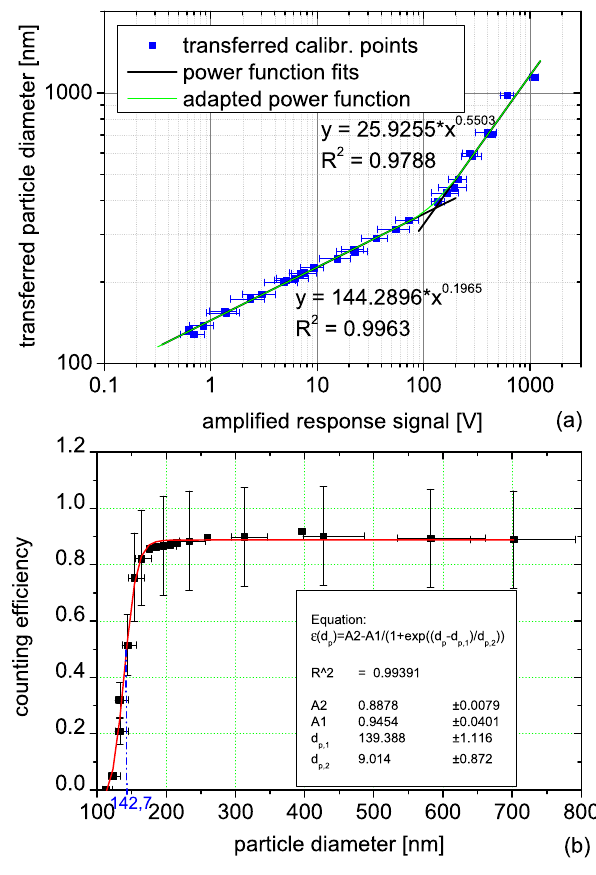
Fig. 2. OPC size calibration (left panel) and counting efficiency (right panel) obtained from laboratory measurements with latex and ammonium sulfate. All calibration points were transferred to the re- fractive index of mid-latitude upper tropospheric (UT) aerosol parti- cles ( n =1.48–0.0143i, see Table 1) using a Mie scattering program. The adapted fit function (green) is a combination of the two power function fits.